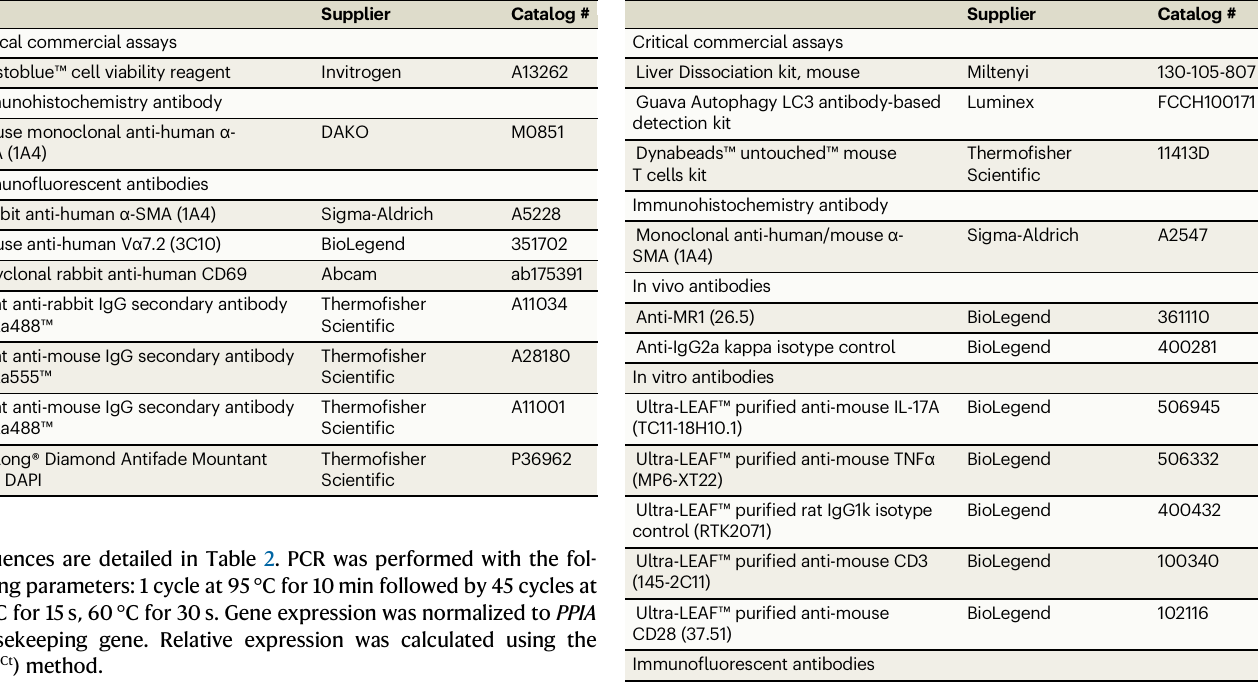
Table 3 | List of reagents for human experiments Table 4 | List of reagents for mouse Supplier